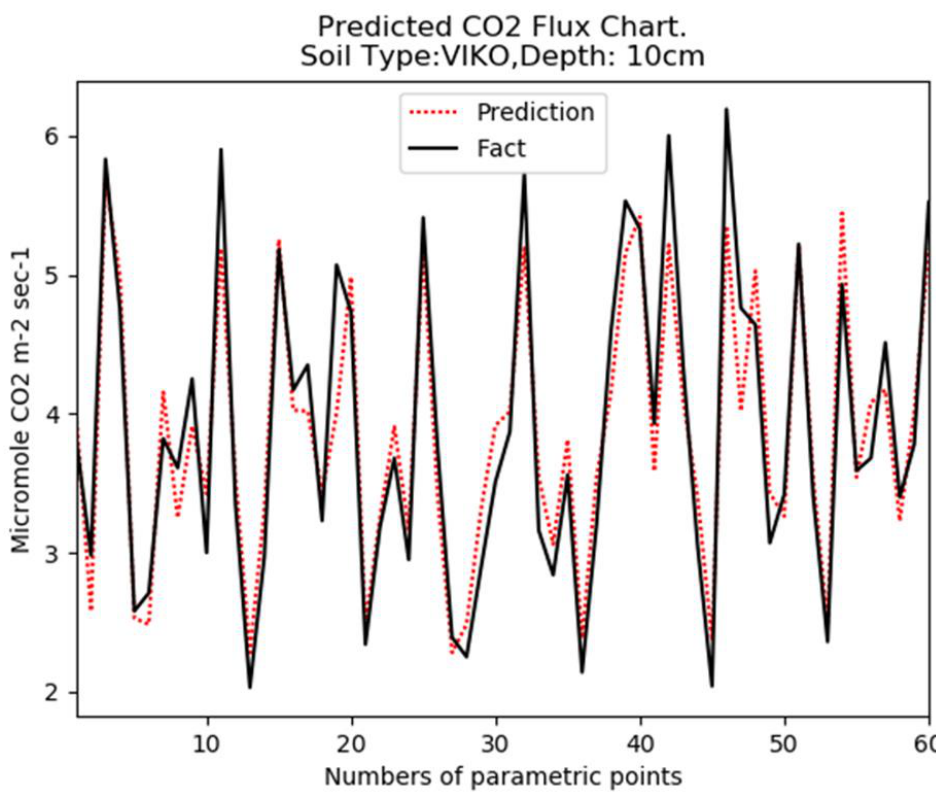
Figure 4. Regression approximation results in experiment 3.